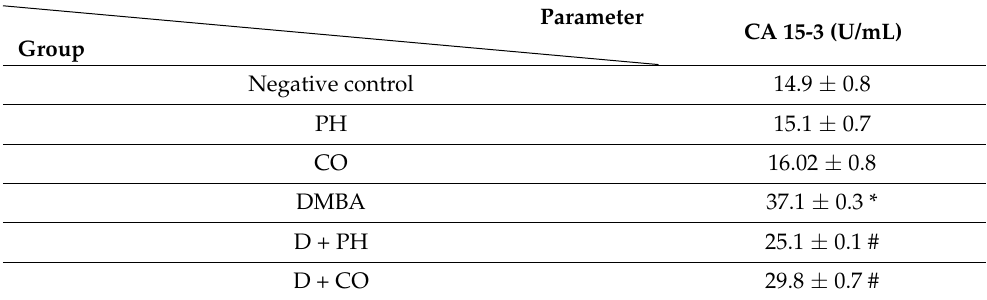
Table 3. Results of analysis of CA 15-3 in different groups. Values are means ± SE of 10 rats.